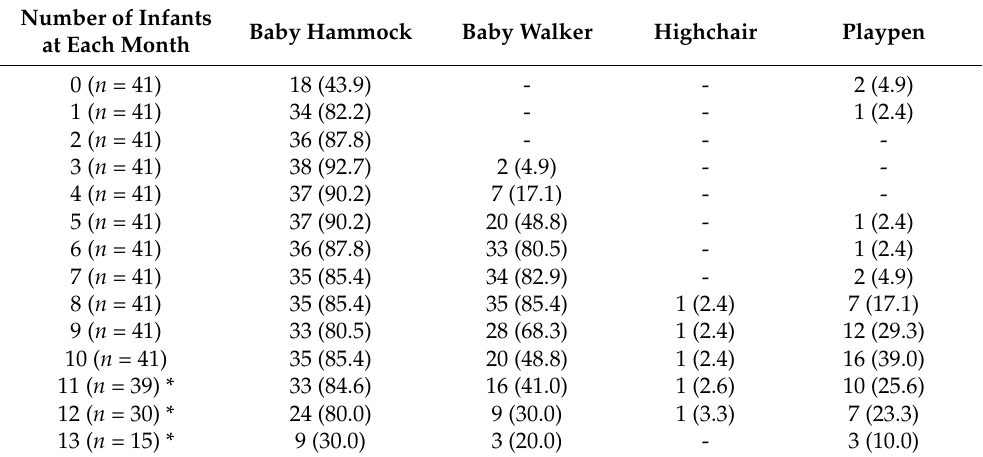
Table 2. Number of infants (%) aged from 0 to 13 months who used equipment during childcare. Number of